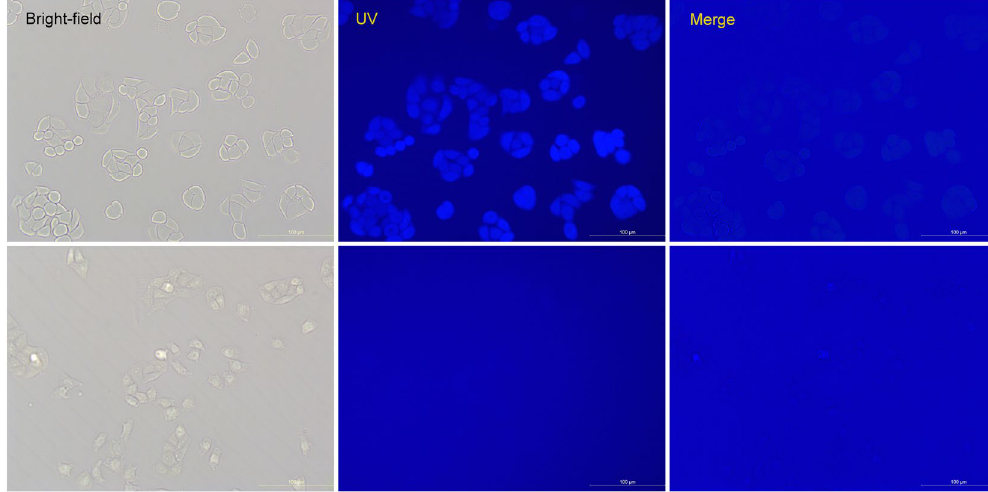
Figure 9. Fluorescence images of HeLa cells. Upper: HeLa cells were treated with 20 μ M NL-AC for 0.5 h; Lower: HeLa cells were preincubated with 1 mM NEM for 2 h and then with 20 μ M NL-AC for 0.5